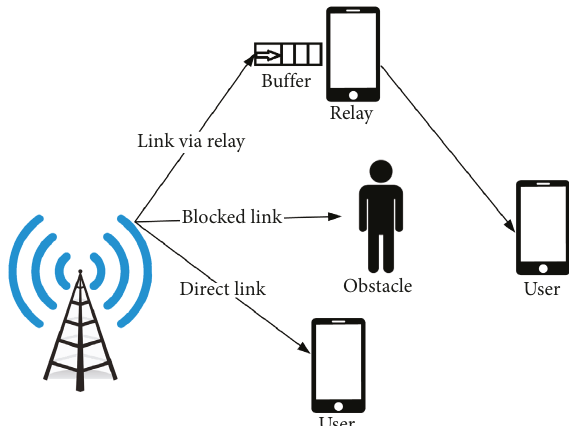
Figure 1: Relay-assisted mm-wave network with buffering capa- bilities in the system